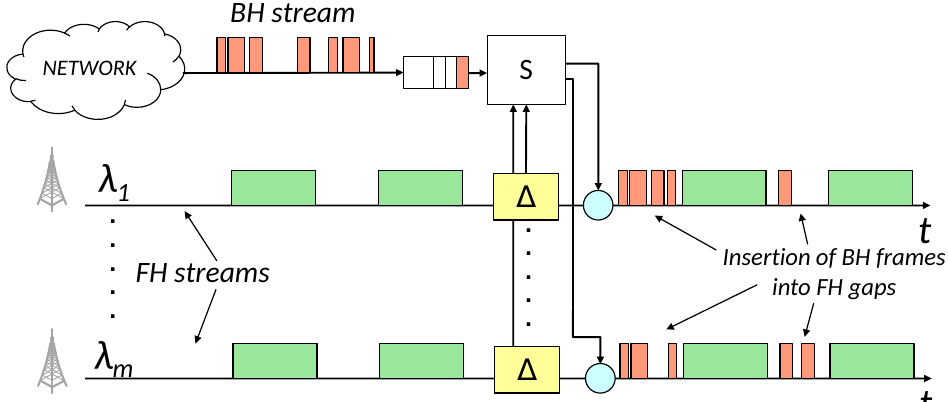
Figure 2. Integrated Hybrid Node (IHN) multiplexing